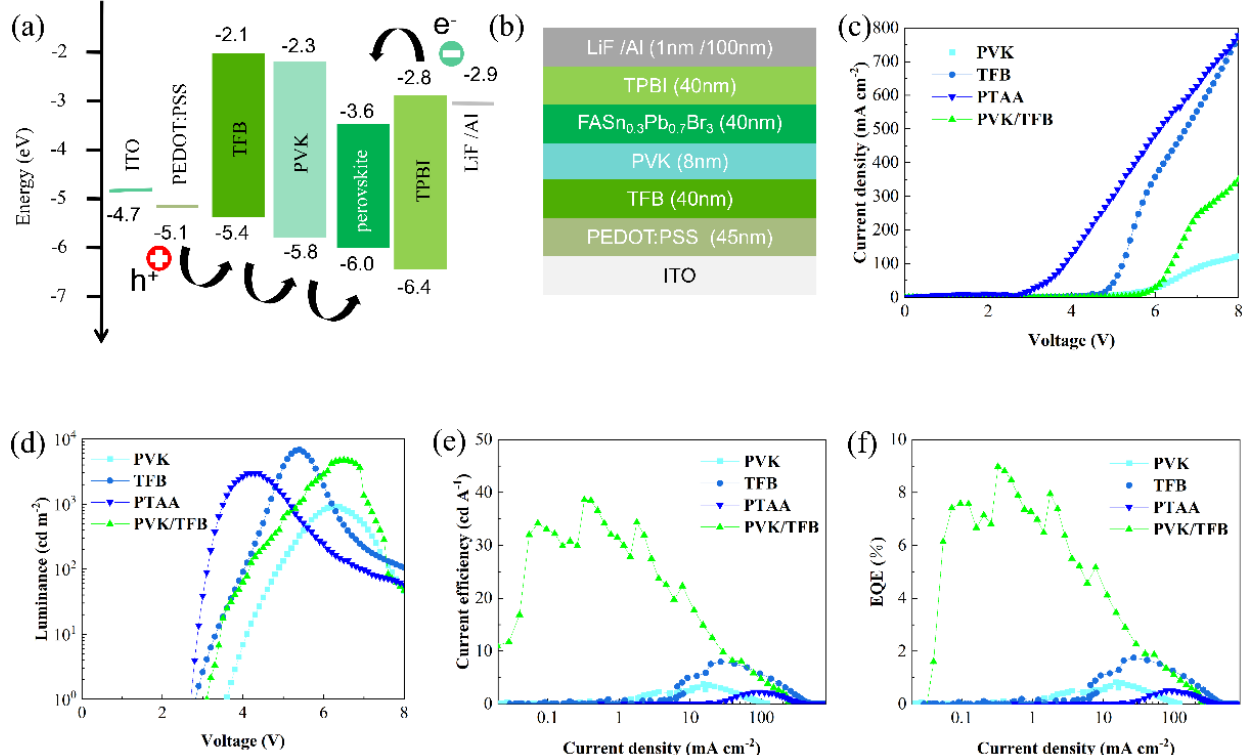
Figure 5. The performance curves of the devices based on single HTL of PVK, TFB, PTAA and double TFB/PVK HTL devices. ( a ) The energy level diagram of TFB/PVK HTL PeLED and ( b ) device configuration of the as-fabricated PeLED based on double HTLs. ( c ) Current density − voltage, ( d ) Luminance − voltage, ( e ) EQE − current density, and ( f ) Current efficiency − current density characteristics of FAPb 0.7 Sn 0.3 Br 3 NC PeLEDs.